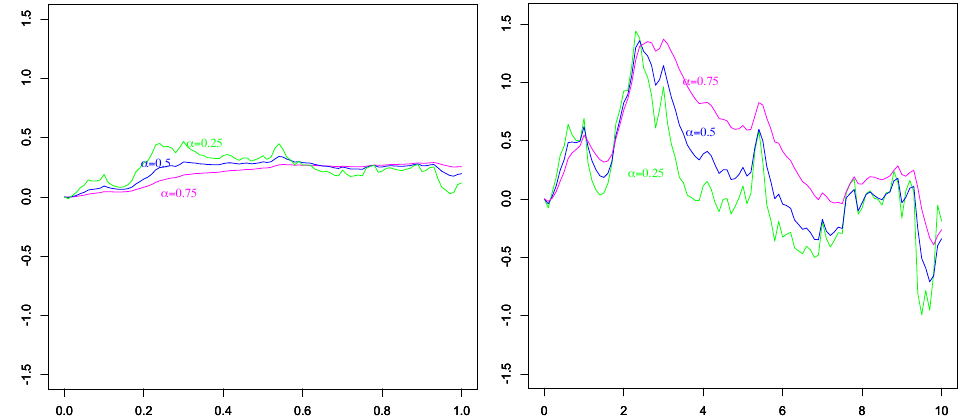
Figure 3. Some simulated sample paths of FIBM ( left ) and of FIOU ( right ) for some values of α (specified by labels inside the figure). In both examples we set N = 100, but the time discretization step h is 0.01 on the left and 0.1 on the right. The seed of the random generator is the same for all simulated paths. (Values of time t are on the horizontal